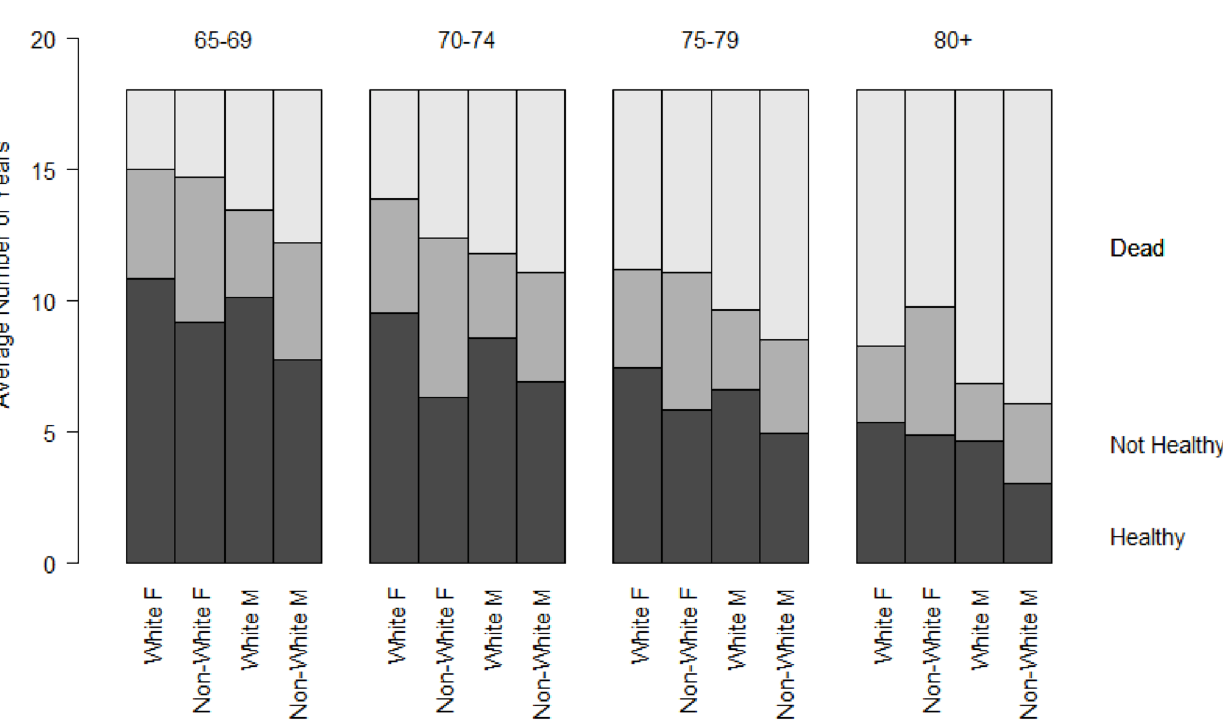
Figure 1. Cumulative years of healthy life (YHL) during 18 years of follow-up by age, sex, and race